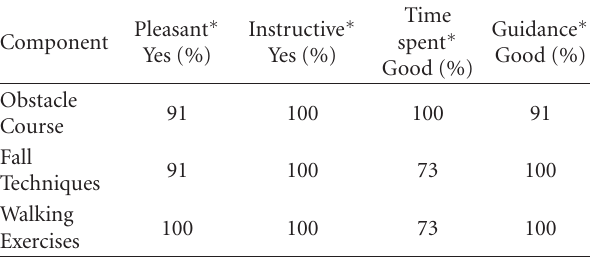
Table 3: Participant satisfaction regarding the FALLS